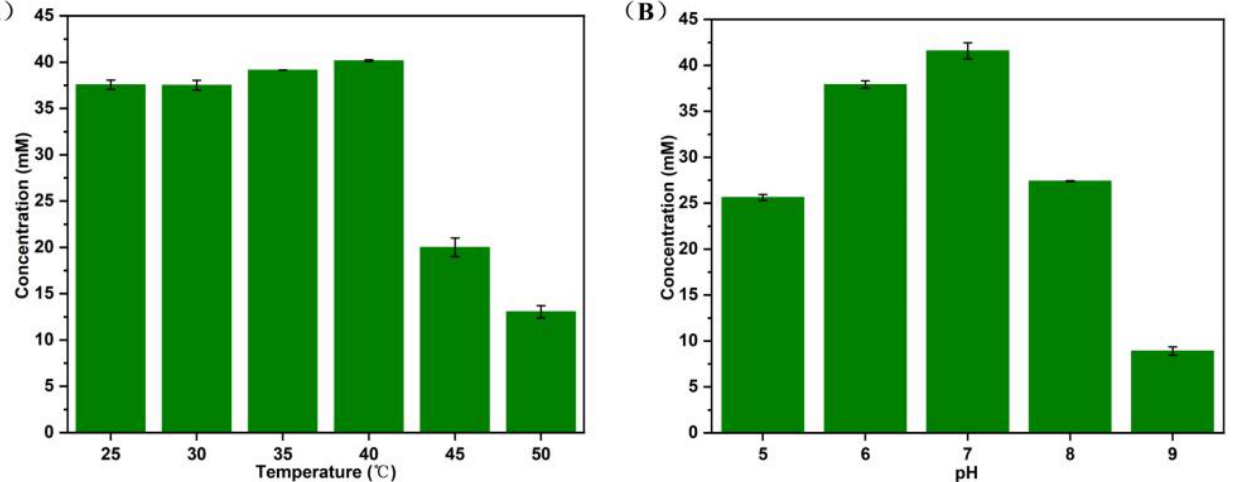
Figure 4. Factors influencing cascade catalytic oxidation of veratryl alcohol. ( A ) Temperature; ( B ) pH. (Reaction conditions: [ Pe AAOx] = 30 µ M, [ Aae UPO] = 2 µ M, [veratryl alcohol] = 50 mM (pre-dissolved in acetonitrile), 500 rpm and 24 h).